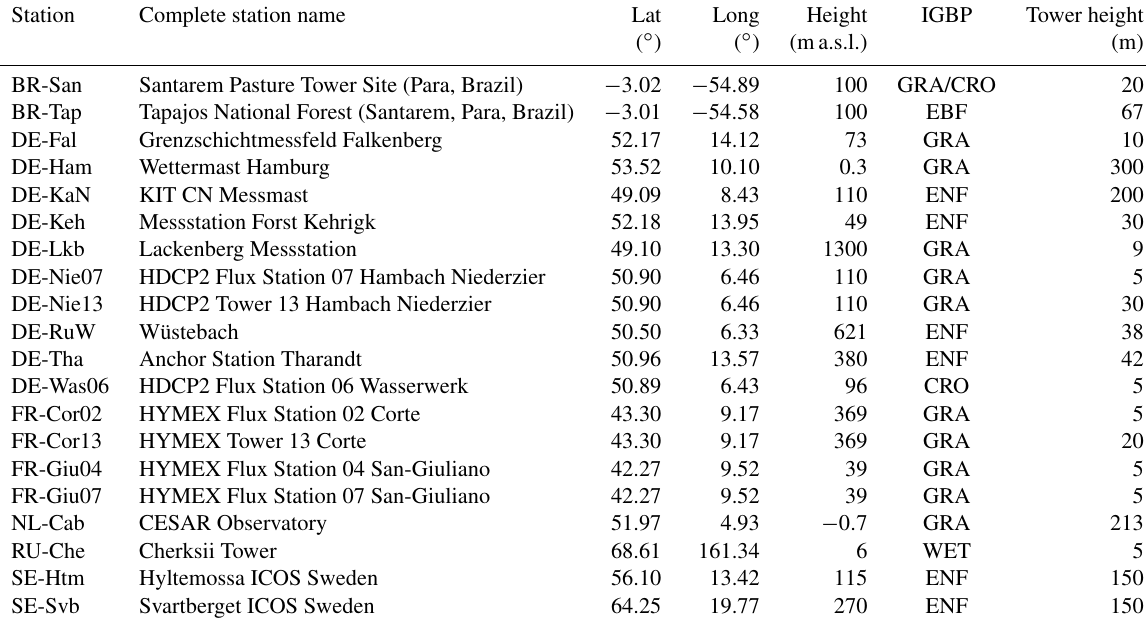
Table A1. Station information for all of the meteorological towers utilised in the study. Land use classification follows the International Geosphere–Biosphere Programme (IGBP) standards: evergreen needle-leaf forests (ENF), evergreen broadleaf forests (EBF), grasslands (GRA), permanent wetlands (WET) and croplands